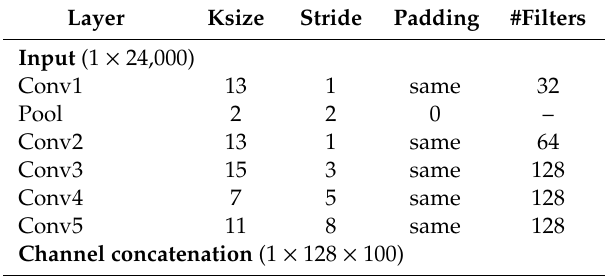
Table 1. Architecture of the 1d network.